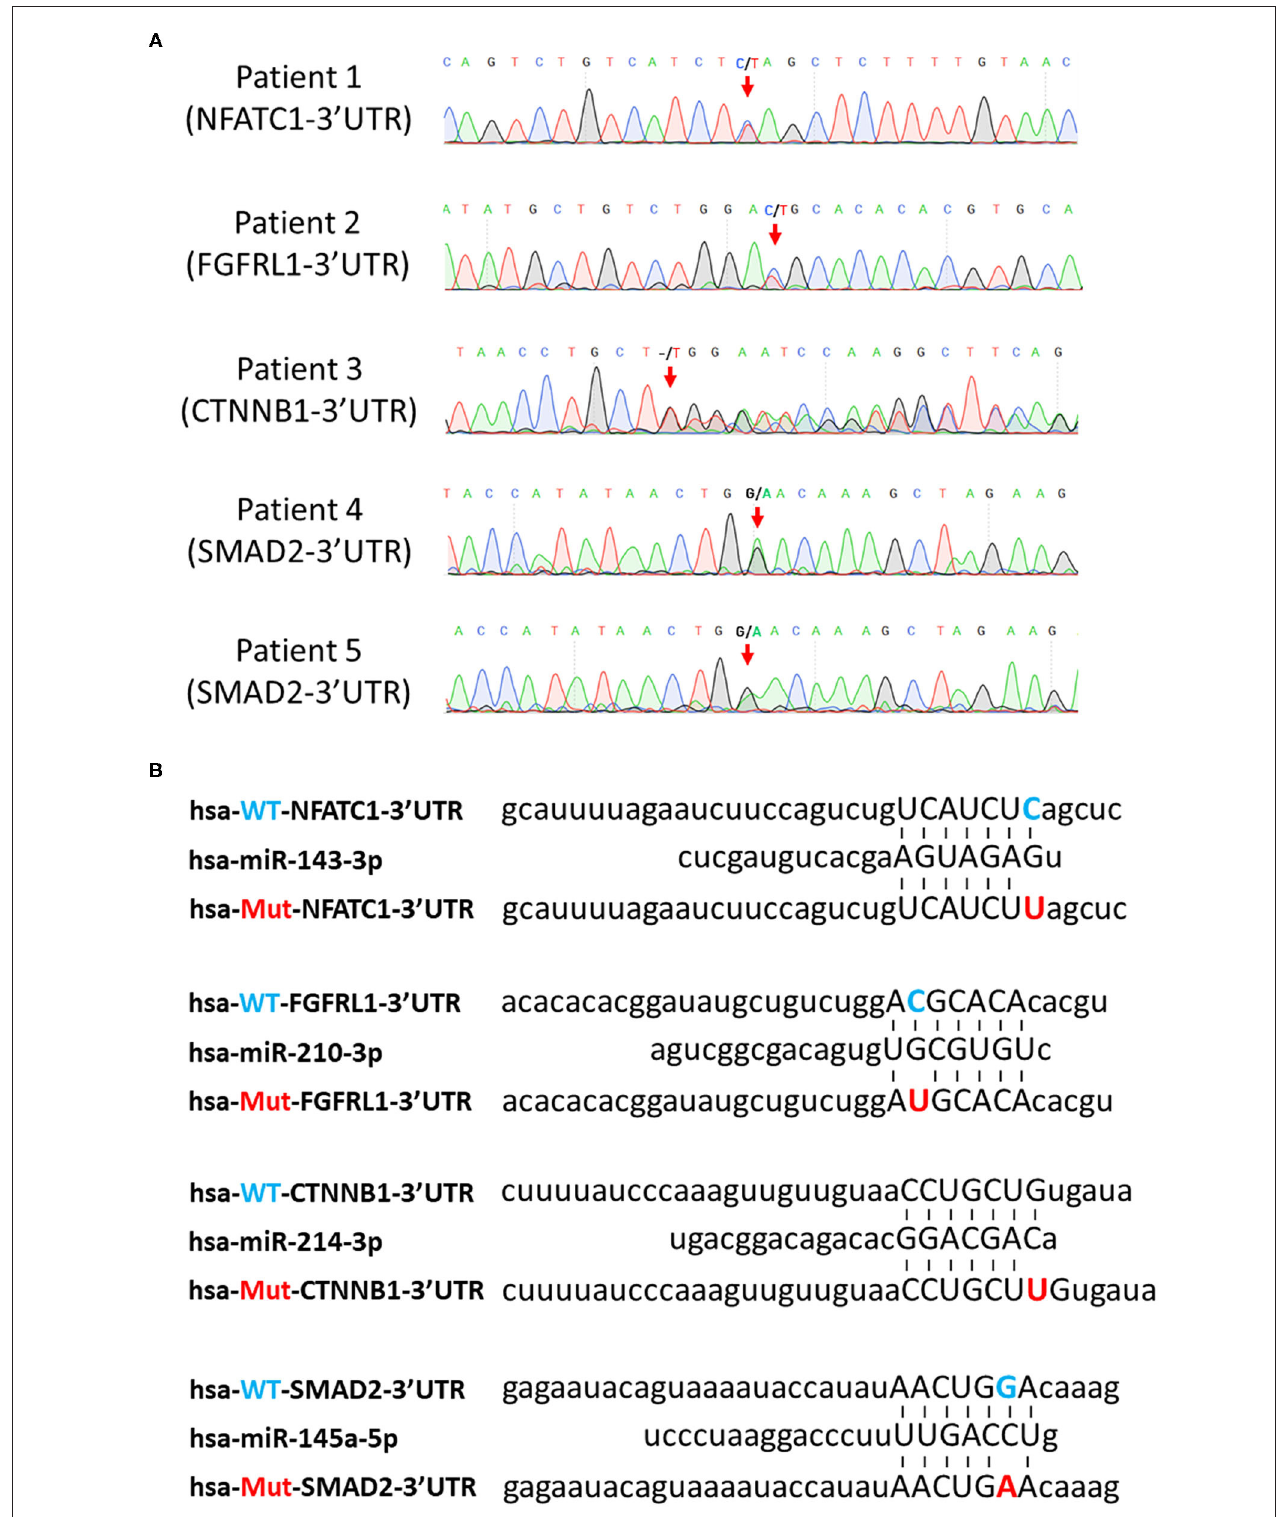
FIGURE 3 | Prediction of SNV-mediated miRNA mis-regulating on their downstream targets. (A) Confirmation of selected SNVs by Sanger sequencing. Red arrows indicate the SNVs. (B) Prediction of pairing between the seed sequence of miRNAs and the SNV-involved mRNA 3 ′ UTR regions. Blue letters indicate wild-type nucleotides, and red letters indicate mutant nucleotides. SNV, single-nucleotide variant; miRNA, microRNA.